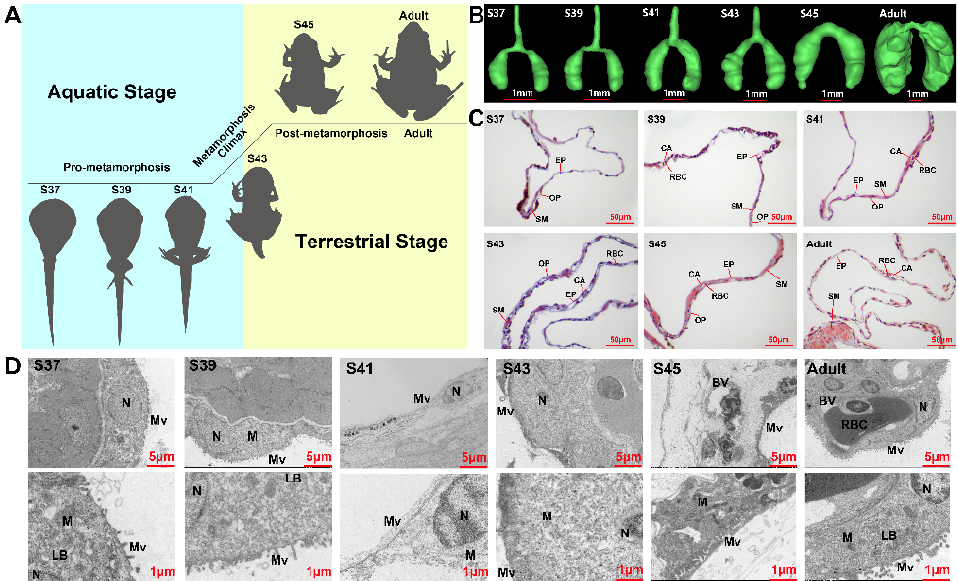
Figure 1. Structural variations of lung with developmental stages. ( A ) Experimental design for this study. Six developmental stages comprising four developmental phases (pro-metamorphic, metamorphic climax, post-metamorphic, and adult phases) with their corresponding habitats. ( B ) Morphological appearance form under micro-CT in different developmental stages ( n = 2 each stage). ( C ) Histological and ( D ) ultrastructural characteristics of the lung in different developmental stages ( n = 3 each stage): CA, capillary; EP, epithelium; RBC, red blood cell; SM, smooth muscle; OP, outer pleura. LB, lamellar body; M, mitochondria; Mv, microvillus; N,